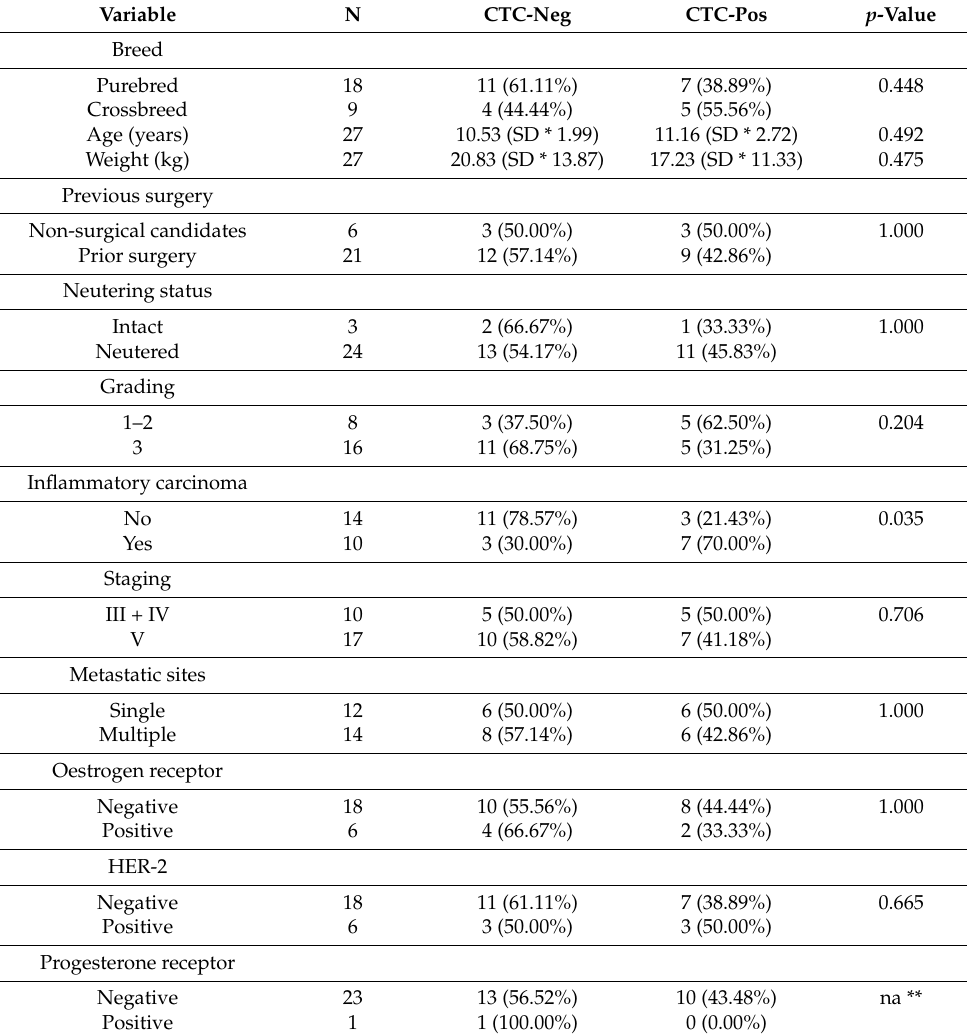
Table 1. Clinical-pathological characteristics of dogs’